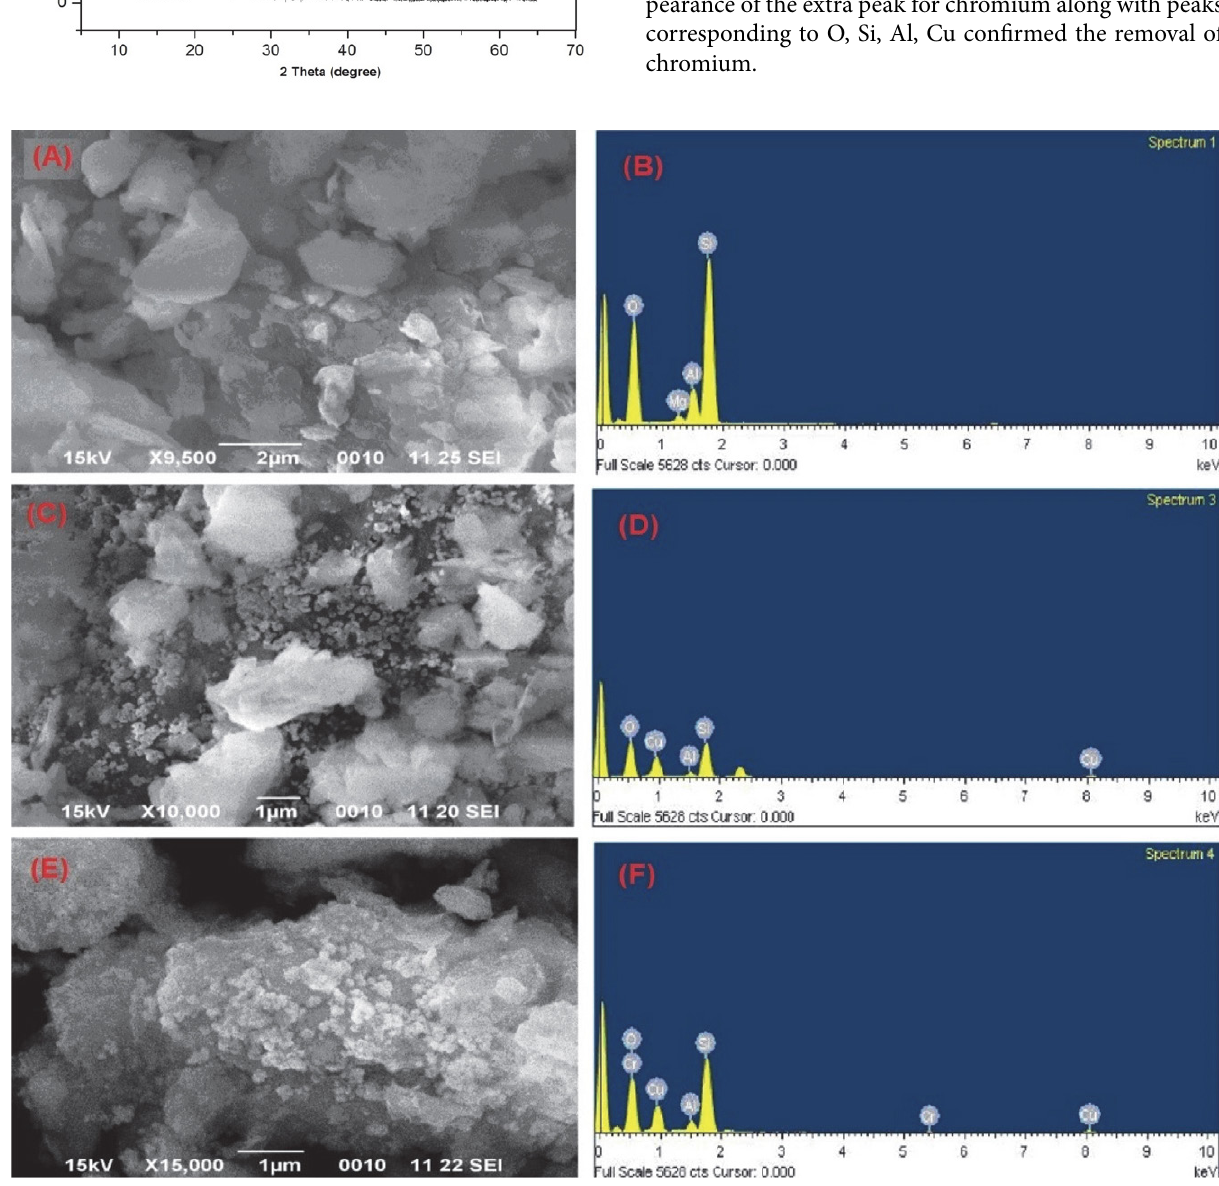
Figure 4: (A) SEM image of pure MMT K10 (B) EDX image of pure MMT K10 (C) SEM image of MMT K10 supported CuONPs (D) EDX image of MMT K10 supported CuONPs (E) SEM image of MMT K10 supported CuONPs after removal of Cr(VI) (F) EDX image of MMT K10 supported CuONPs after removal of